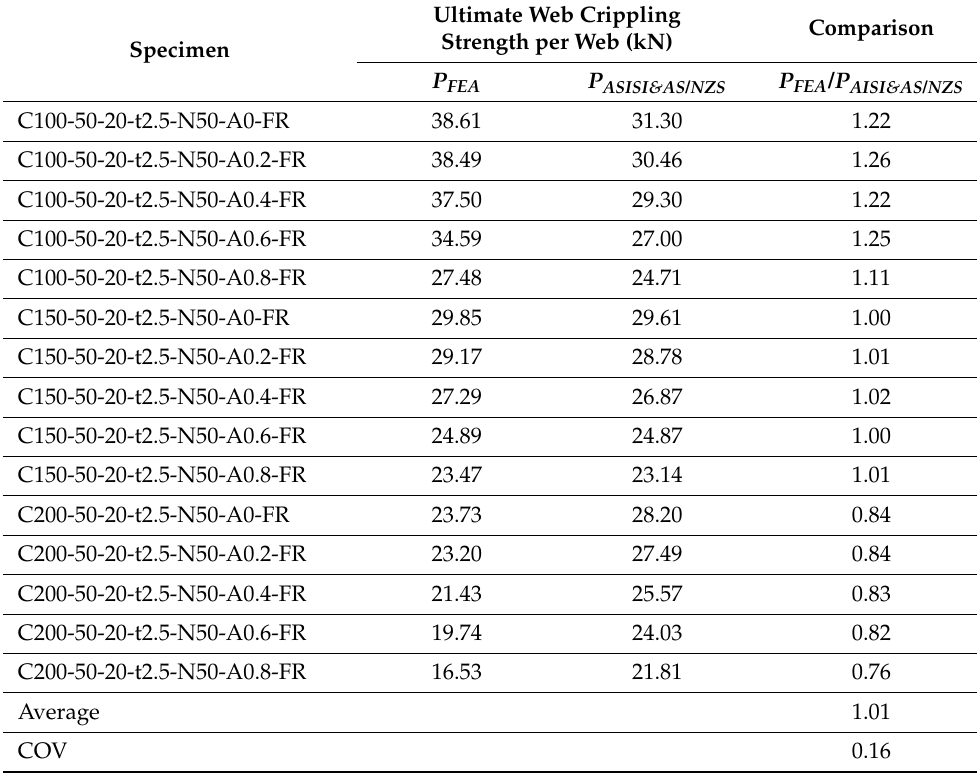
Table 5. Comparison of FEA results with current design